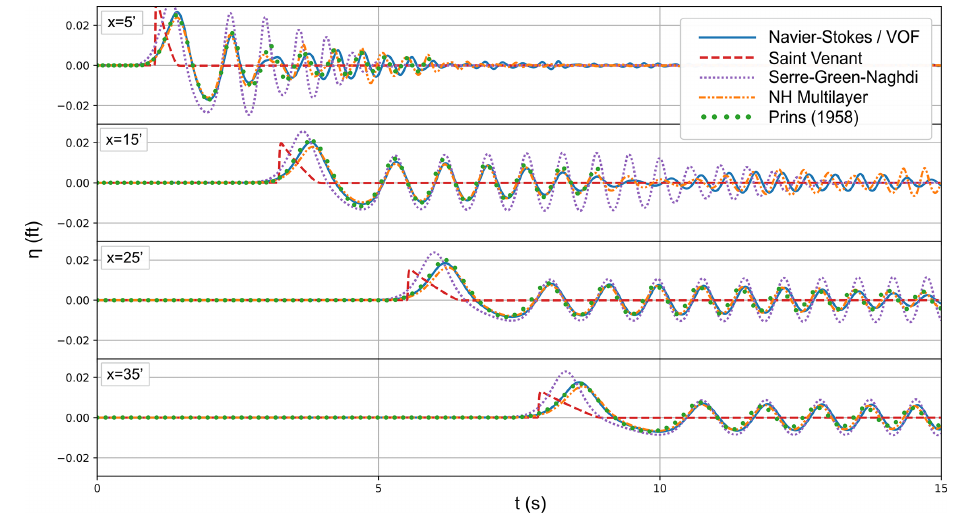
Figure 3. Model comparison of time series of waves produced by a disturbance of Q = 0 . 3ft, and L = 1 metric conversion of feet to metres, divide by 3.281.